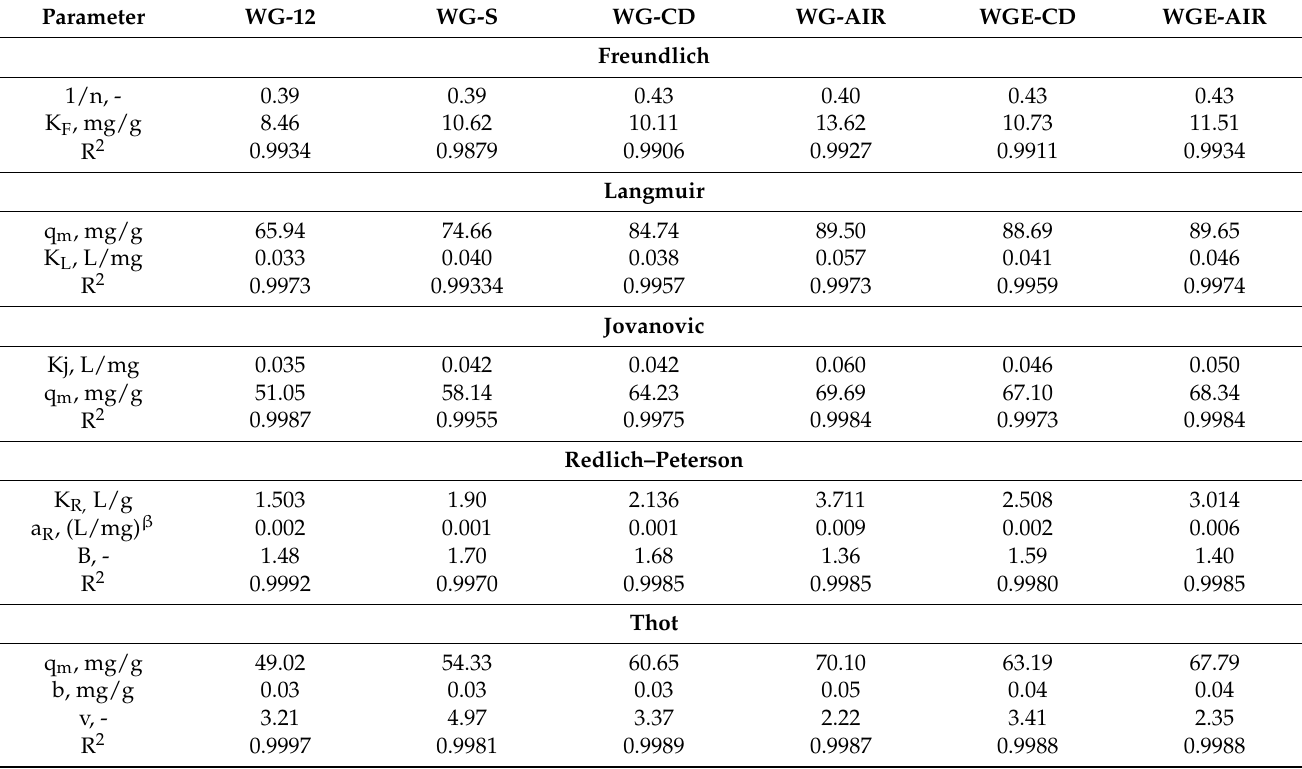
Table 11. Oxytetracycline adsorption isotherms on modified activated carbons.